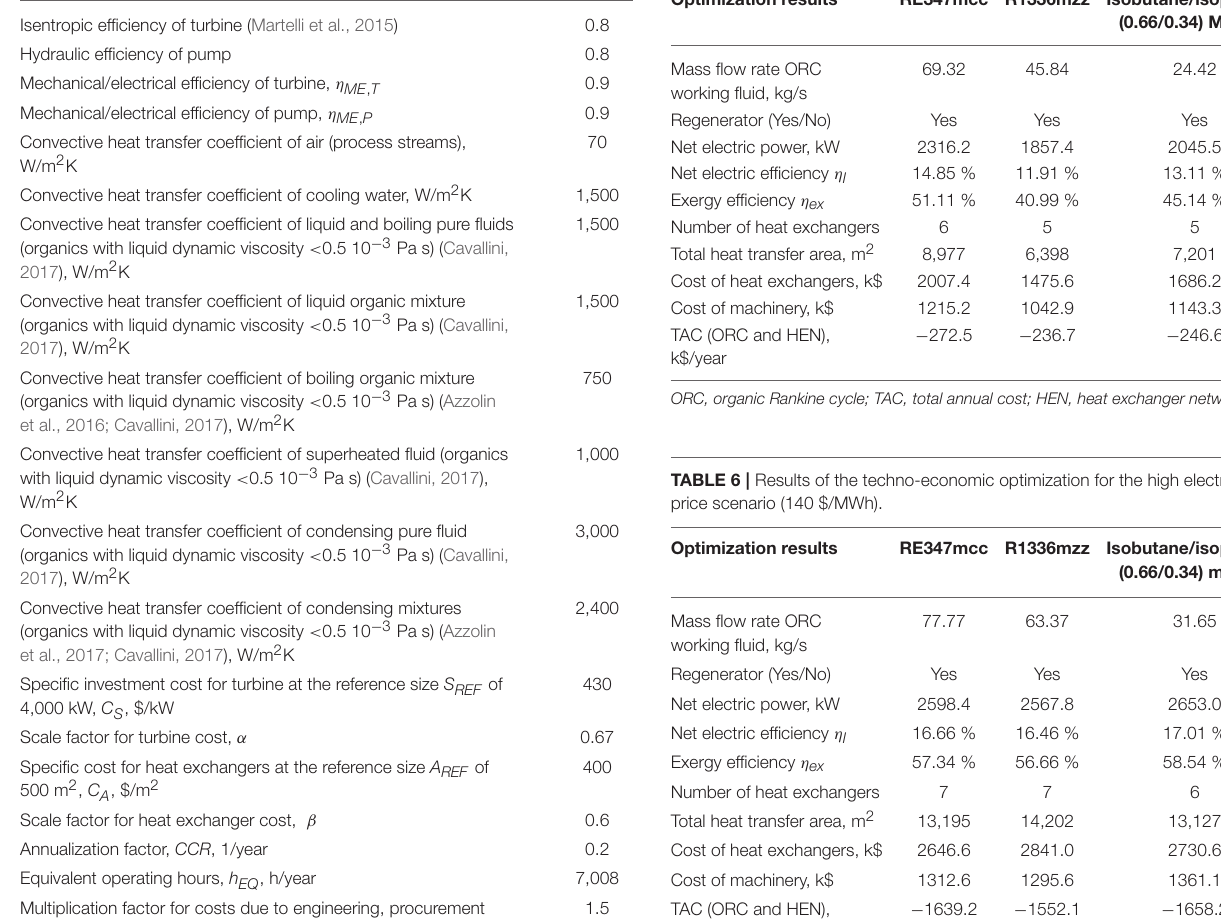
TABLE 5 | Results of the techno-economic optimization for the low electricity price scenario (70 $/MWh). Optimization results